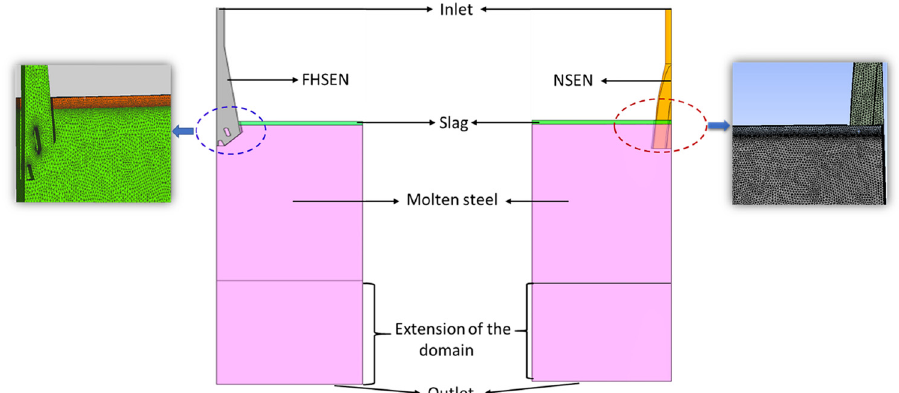
Figure 4: Funnel mold models and local